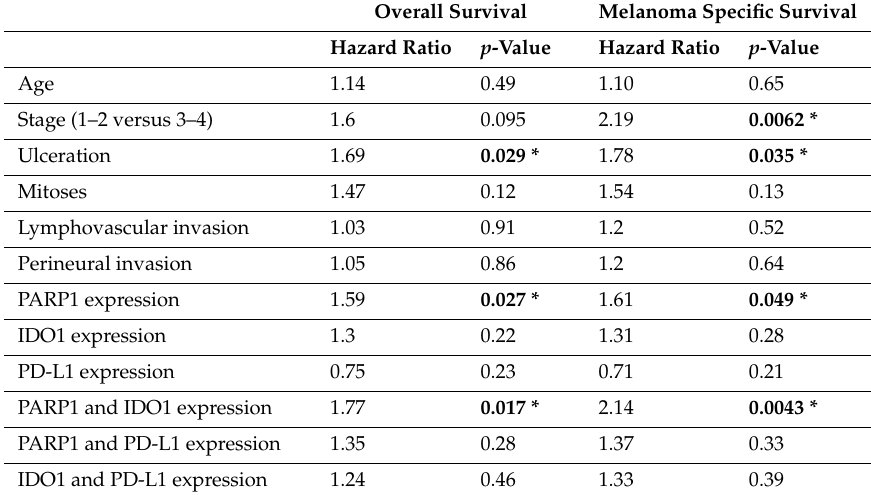
Figure 4. Kaplan–Meier curves illustrate the associations between high PARP1 expression and worse overall survival (log-rank p -value = 0.026) ( A ), and high PARP1 and high IDO1 expression and worse MSS (log-rank p -values = 0.0034) ( B ). Table 2. Univariate Cox proportional hazards